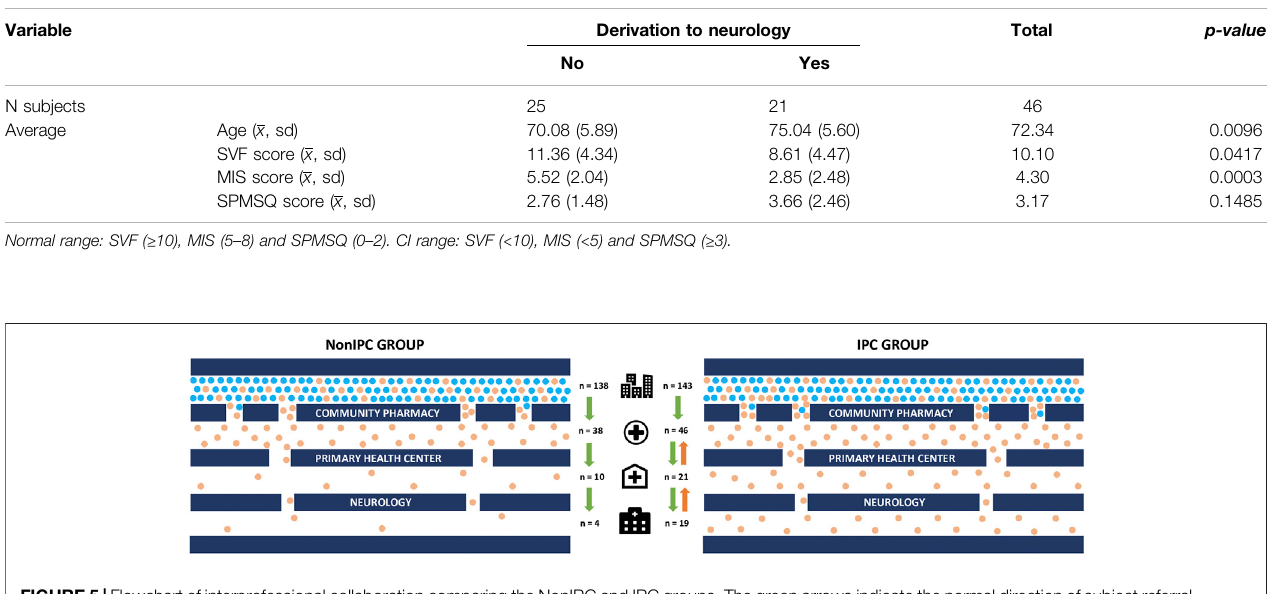
FIGURE 5 | Flowchart of interprofessional collaboration comparing the NonIPC and IPC groups. The green arrows indicate the normal direction of subject referral, while orange arrows represent the bidirectional communication and referral among the different partners of the IPC group. In such group, primary care physicians refer subjects who suspect CI to pharmacies where they are invited to join the project. Whereas neurologists refer individuals without diagnostic to primary care for follow